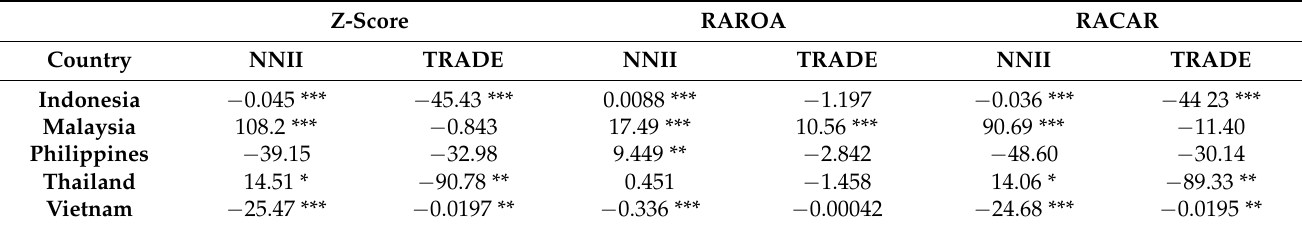
Table 7. Business model for individual